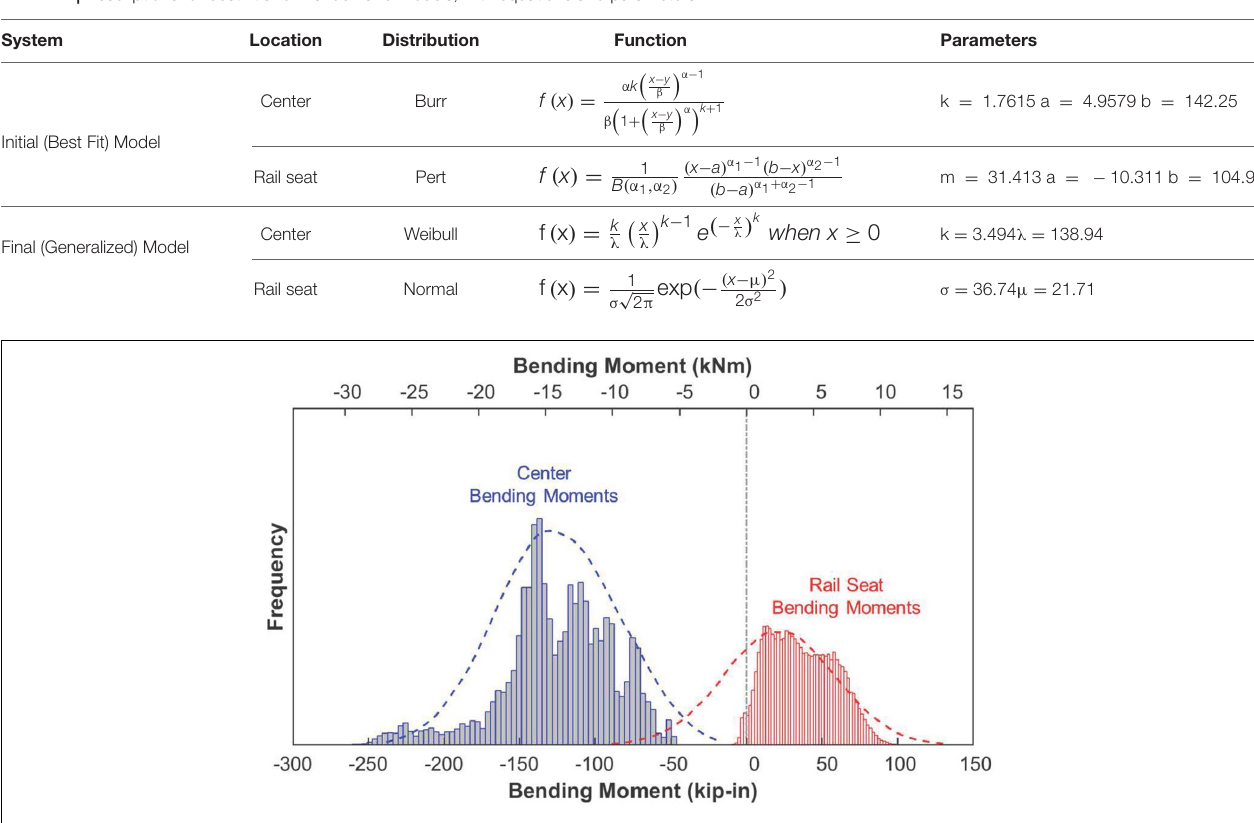
FIGURE 5 | Fitted PDFs overlaid on raw data of sleeper rail seat and center bending moments used for demand models for HAL